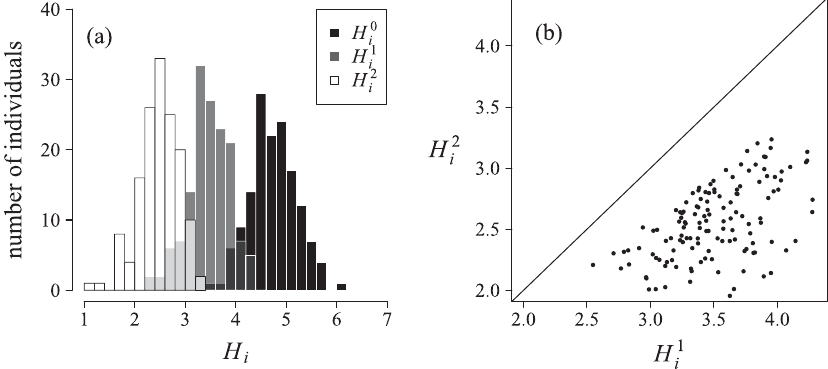
FIG. 4. (a) Histograms of the entropies for D